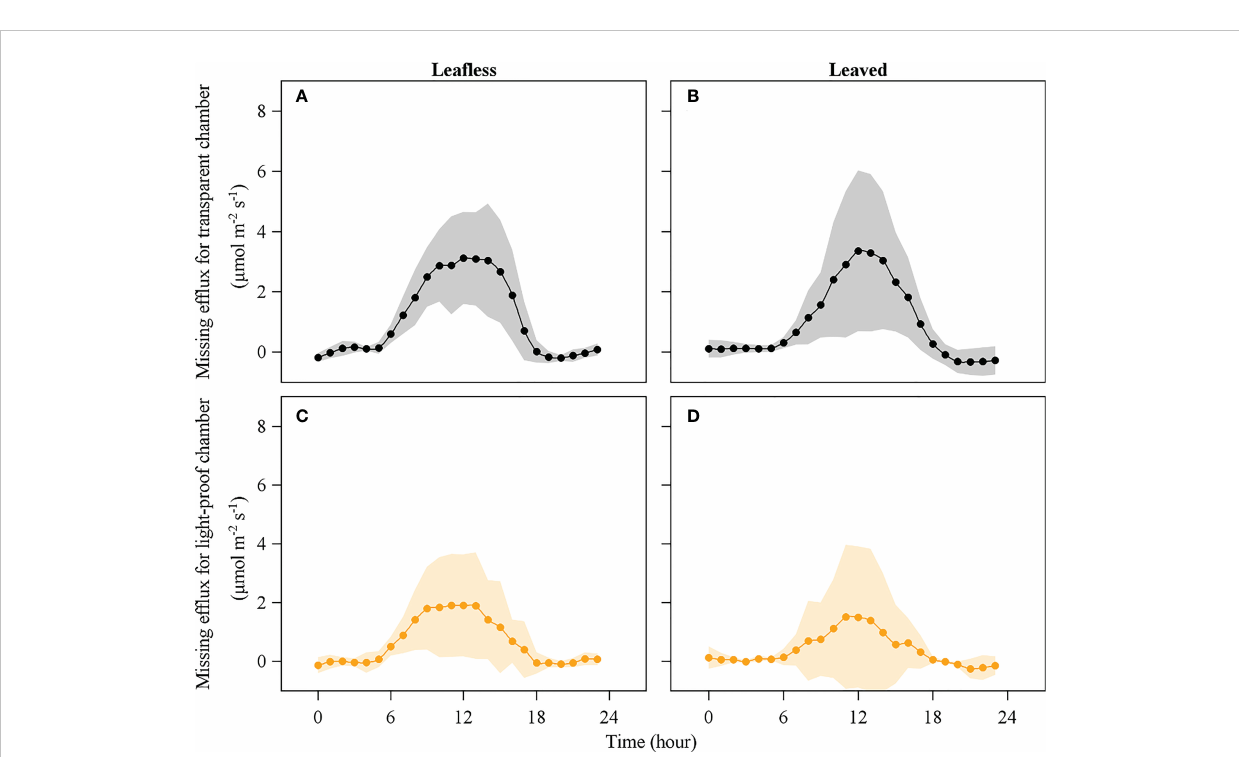
FIGURE 8 Missing ef fl ux of culm respired CO 2 in lea fl ess (A) , (C) and leaved (B) , (D) stages for transparent and light-proof chambers. Note that missing ef fl ux is the difference between the theoretical culm respiration and the surface-released CO 2 ef fl ux.